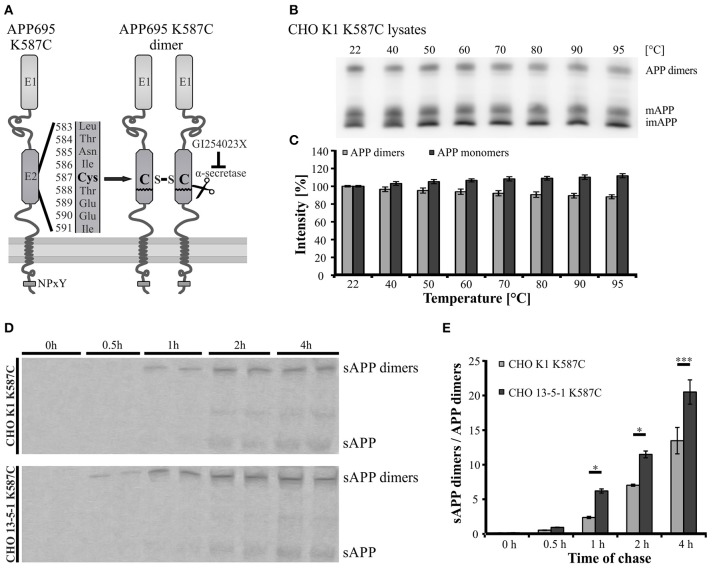
Faster trafficking of SDS- and heat-stable APP cis-dimers in LRP1-deficient cells. (A) Schematic representation of the APP Cys-mutant encoded by the pLHCX-APP695 K587C construct and its resulting cis-dimerization state. (B,C) CHO K1 cells were transiently transfected with the APP695 K587C construct. (B) 24 h post transfection monomeric as well as dimerized APP were detected by the antibody mix 1G75A3 (1:3,000) in cell lysates. (B,C) Heating of samples up to 95°C shows a negligible reduction of the APP dimer signal with a comparable increase in monomeric APP. (D) CHO K1 and LRP1-deficient CHO 13-5-1 cells both stably expressing the dimer bearing APP construct were pulsed with radiolabeled sulfur (35S) for 15 min. Chase was performed after stated time spans prior to immunoprecipitation of APP with the antibody mix 1G75A3 (1:300) and SDS-PAGE. Exposure of the film revealed an earlier occurrence of soluble APP dimers in the conditioned medium of LRP1-deficient CHO 13-5-1 cells (30 min chase) than in CHO K1 cells (1 h chase). (E) Comparison of the sAPP dimer to APP dimer ratio of both cell types shows a significant elevation for CHO 13-5-1 cells beginning after a 1 h chase. Bars represent mean values ± SEM, n = 3; Student's t-test; p < 0.05 (*), p < 0.001 (***).